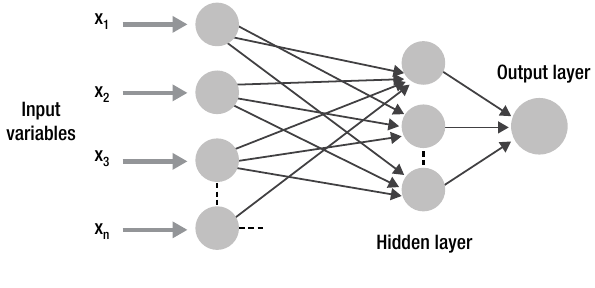
Fig. 1. Feed-forward